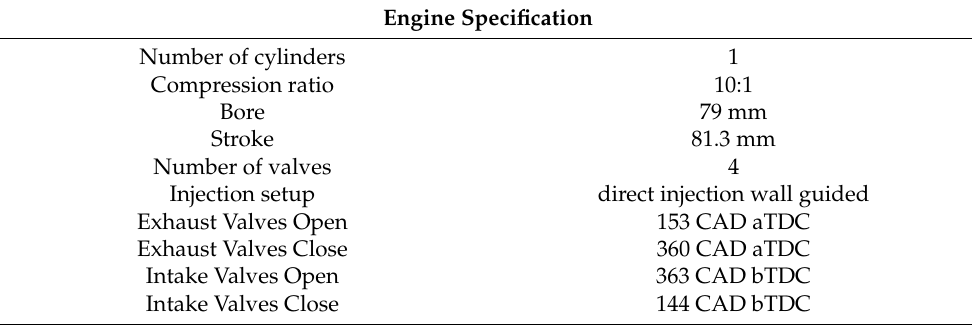
Figure 1. Illustration of the engine used for the experimental trials; the crankshaft housing is not shown so as to render the length of the elongated piston part. Table 1. Engine specifications.